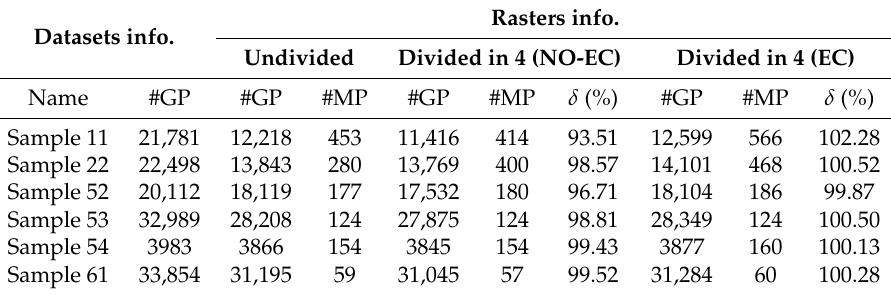
Table 4. Misclassification of points due to the divisions on the datasets and the improvements of our proposal using some of the datasets provided by the ISPRS [32]. Variations in classification quality are measured with the δ metric (higher is